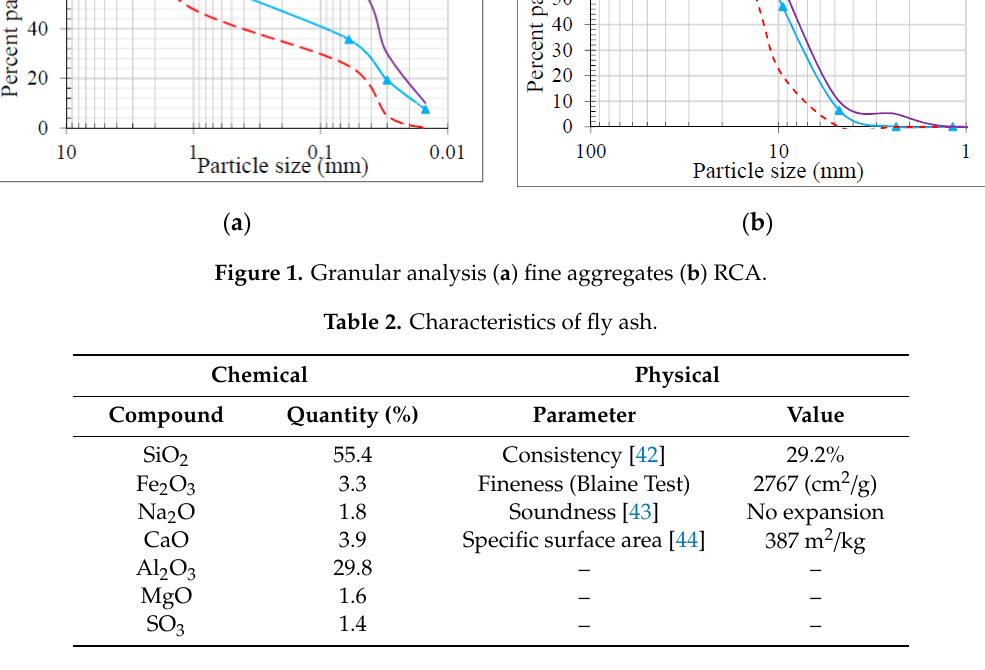
Table 3. Physical and chemical properties of all types of e ffl uent studied in the present